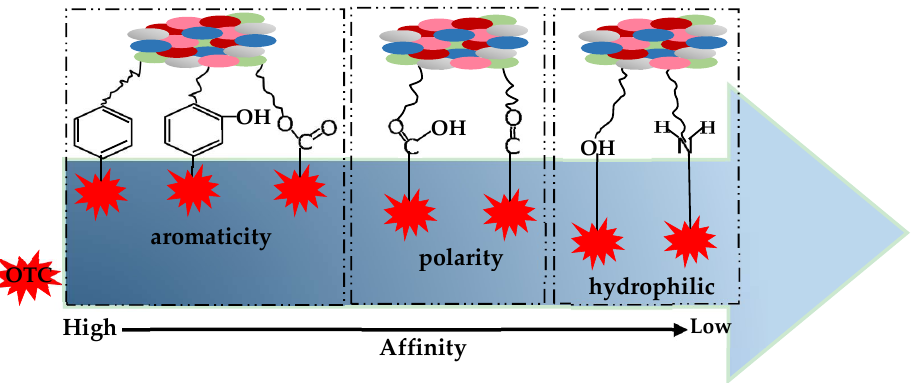
ffi nity of functional groups combined with Figure 12. The affinity of functional groups combined with OTC . Figure 12. The a